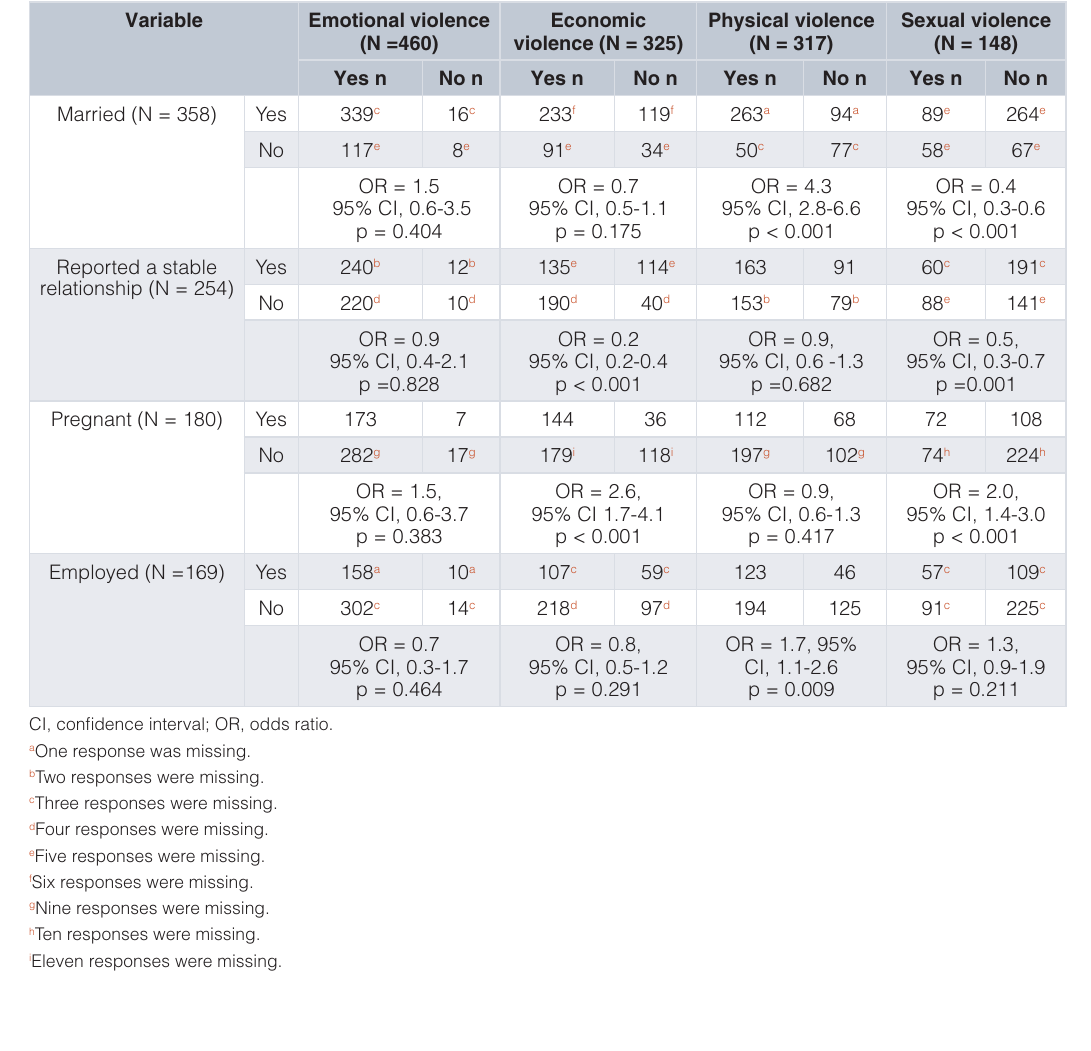
Table 7. Characteristics of the women associated with the types of gender-based violence (n=488).